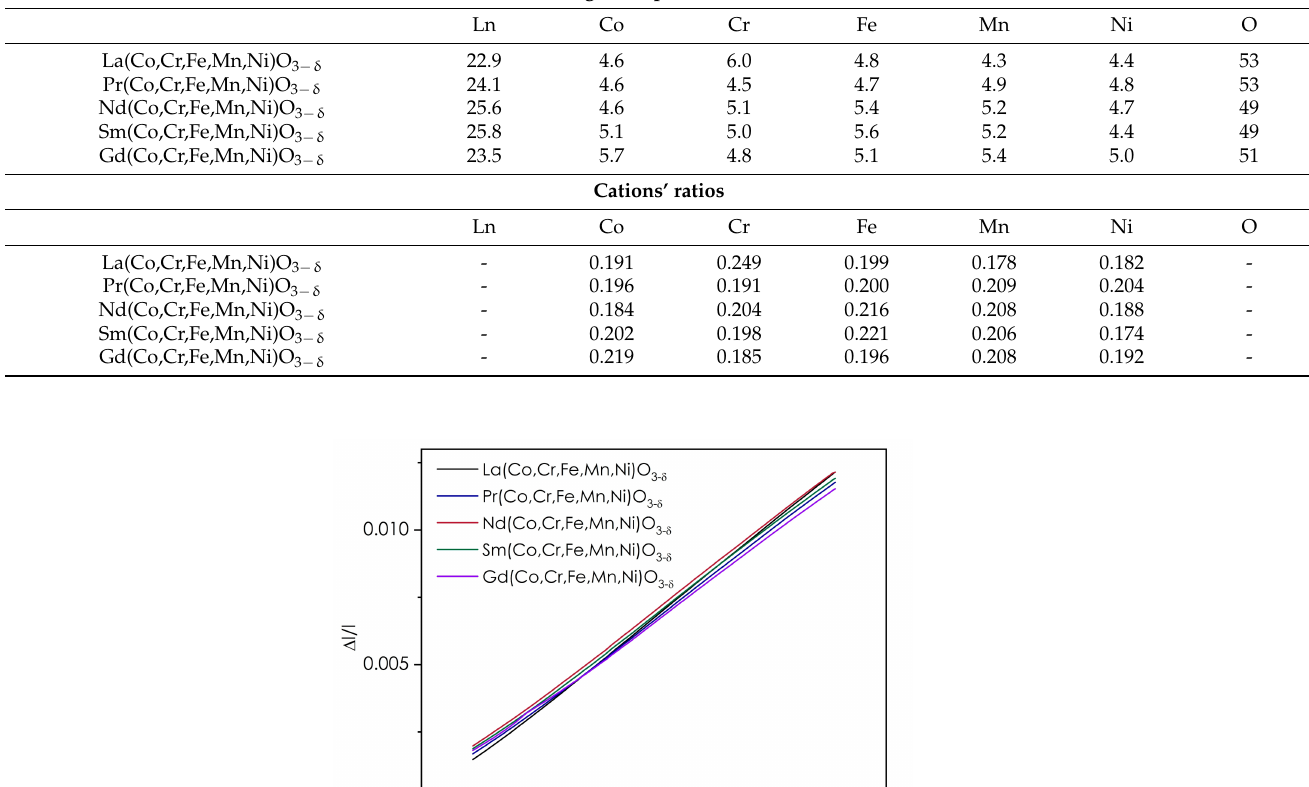
Table 2. Average compositions of the Ln(Co,Cr,Fe,Mn,Ni)O 3 − δ pellets sintered at 1000 ◦ C for 20 h, followed by quenching, as determined by EDS area analysis (error of determination: 0.2–0.9 at.% for cations). The respective ratios for the B-site transition metal cations are also provided, under the assumption that the sum of their molar fractions is equal to 1. Average Composition (at.%)